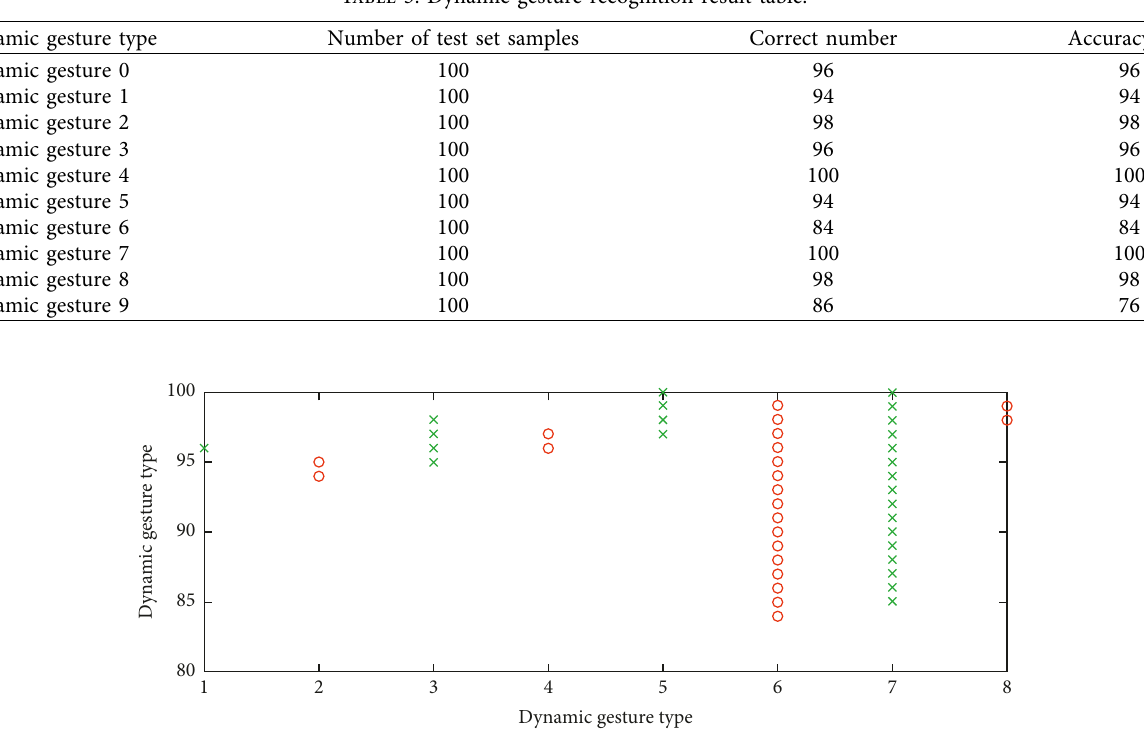
Figure 8: Dynamic gesture recognition accuracy. Table 4: System test-click gesture